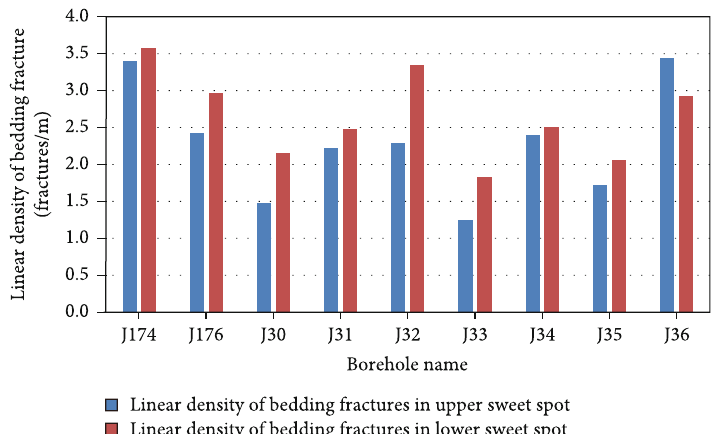
Figure 6: Comparing column chart of bedding fracture linear densities between the upper and lower sweet spots of Lucaogou formation in Jimsar